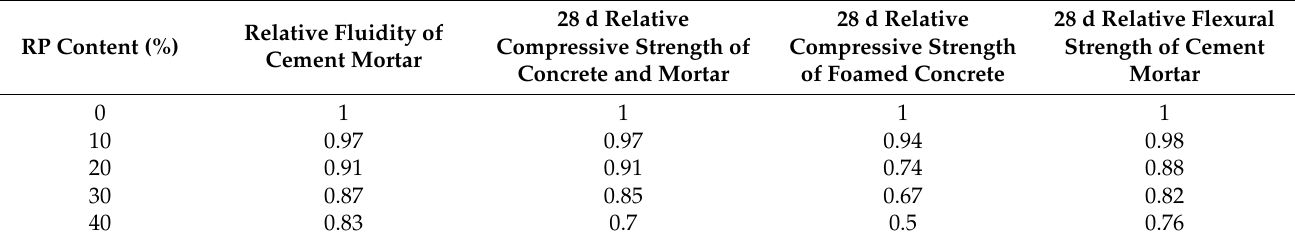
Table 5. Optimal values under each index.